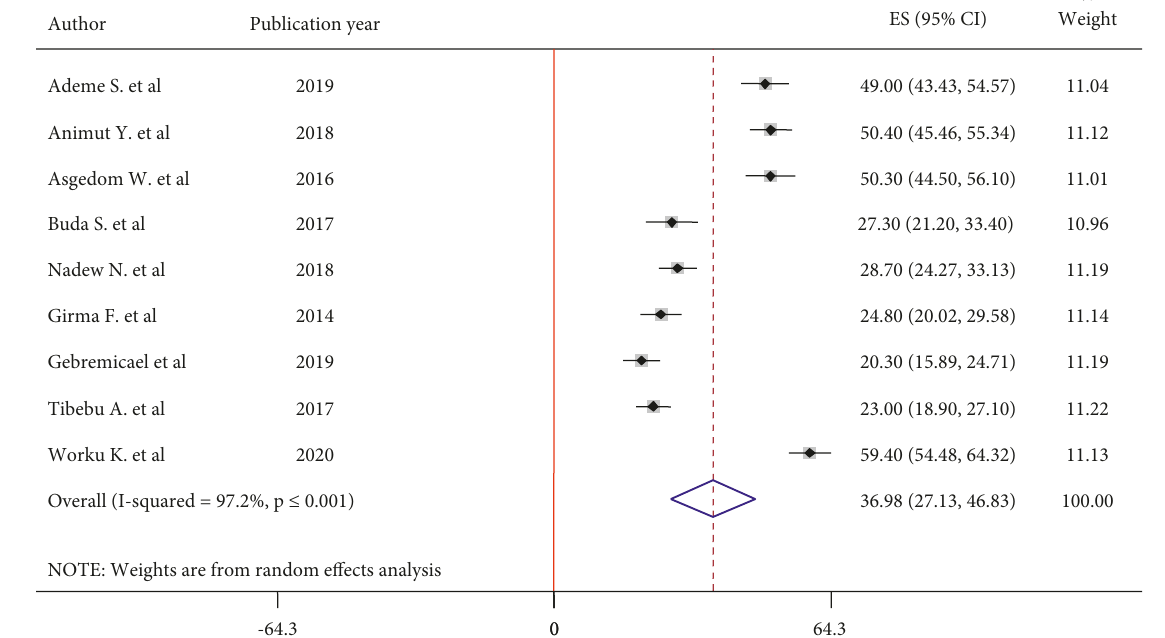
Figure 2: Forest plot depicting the pooled prevalence of self-care adherence among hypertensive patients in Ethiopia,